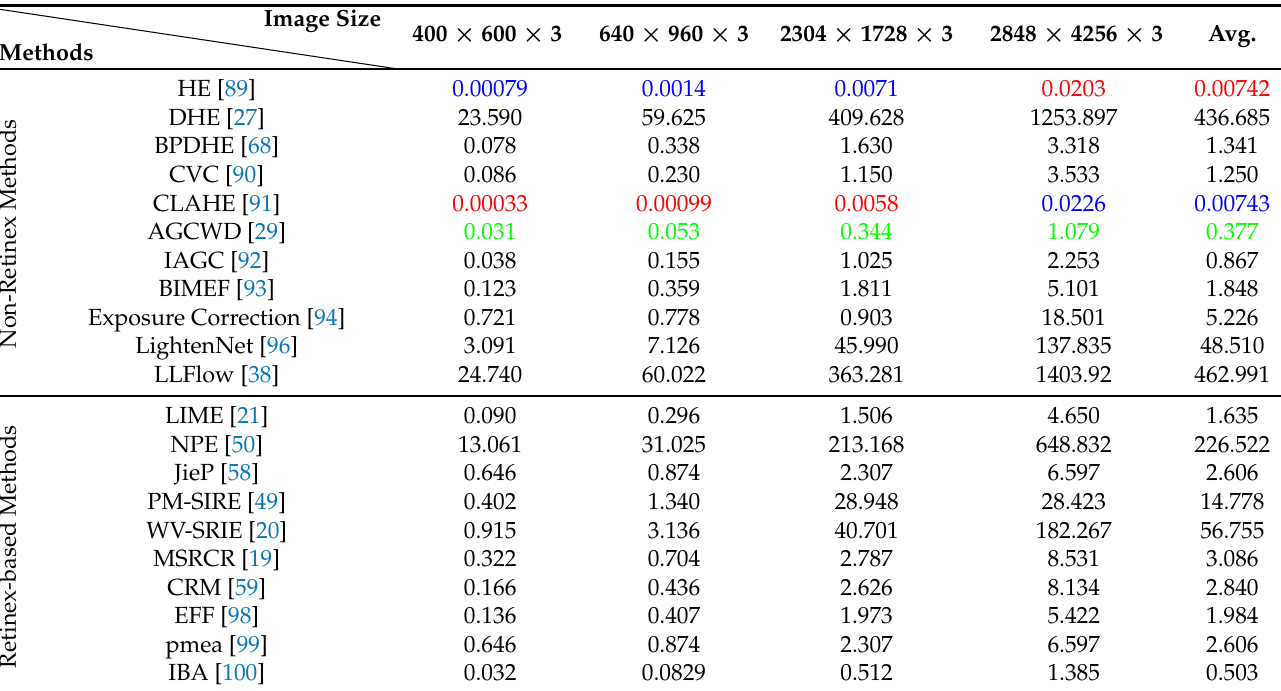
Table 5. Computational time of classical methods in terms of seconds on CPU is reported. The red, blue, and green colors are used to indicate the best, second best, and third best performance, respectively.